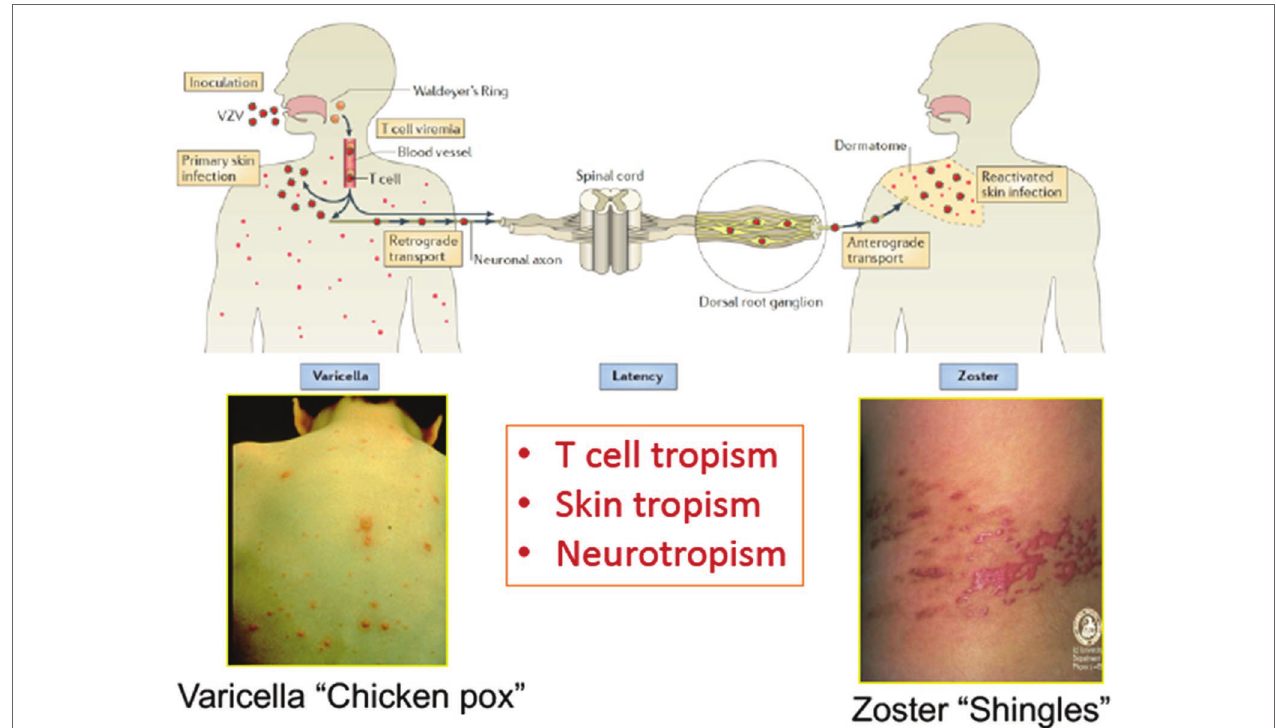
FIGURE 1 | The life cycle of varicella zoster virus (VZV) in the human host. VZV infects the human host when virus particles reach mucosal epithelial sites of entry. Local replication is followed by spread to tonsils and other regional lymphoid tissues, where VZV gains access to T cells. Infected T cells then deliver the virus to cutaneous sites of replication. VZV establishes latency in sensory ganglia after transport to neuronal nuclei along neuronal axons or by viremia. Reactivation from latency enables a second phase of replication to occur in the skin, which typically causes lesions in the dermatome that is innervated by the affected sensory ganglion. Adapted from Zerboni et al.